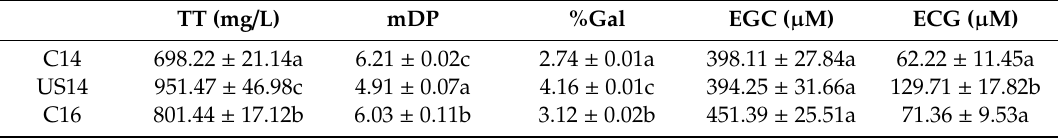
Table 3. Concentration and composition of total tannins determined by the phloroglucinolysis method.